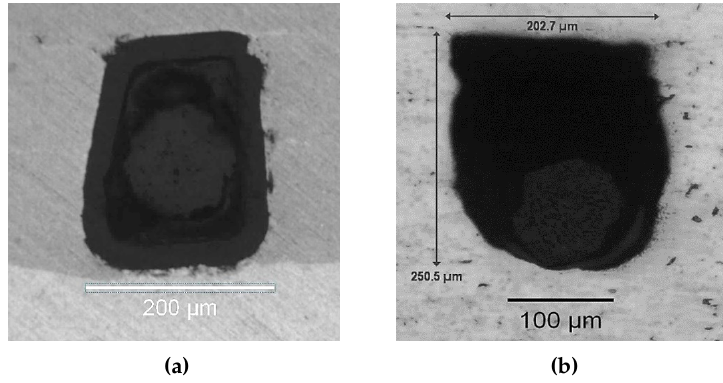
Figure 23. ( a ) Cross-section of an UAM-embedded FBG that has not undergone thermal loading and ( b ) cross-section of the UAM-embedded FBG that underwent cyclic thermal